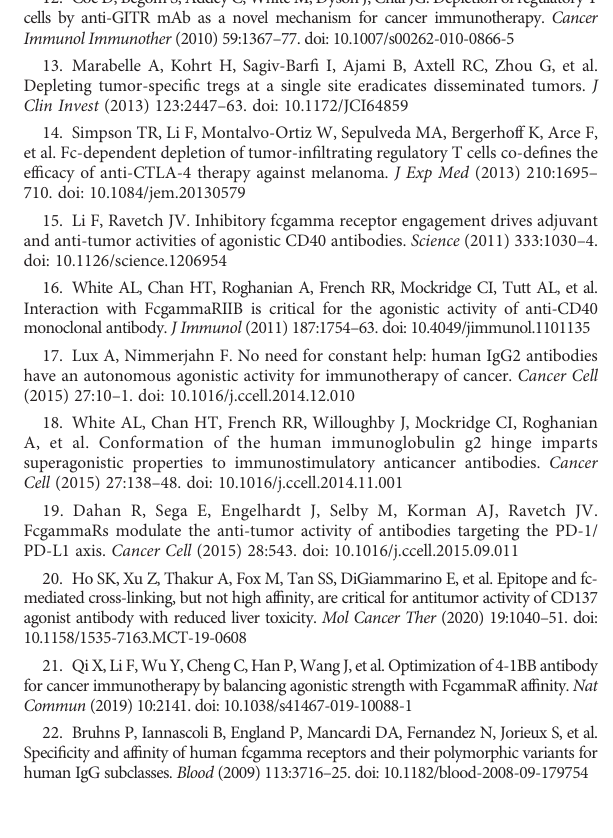
SUPPLEMENTARY FIGURE 5 Effect of urelumab variant injection on serum cytokine levels. Serum cytokine concentrations were determined before and at the indicated time-points after treating humanized mice with 3µg/g (A, C, E) or 6µg/g (B, D, F) of hIgG4, a CD137 or deglycosylated a CD137 PNGaseF variant. Depicted are serum concentrations of (A) IL-1 b (hIgG4: n=3, aCD137: n=6, a CD137 PNGaseF: n=4), (C) IL-8 (hIgG4: n=3, a CD137: n=6, a CD137 PNGaseF: n=4), and (E) IFN- a (hIgG4: n=4, a CD137: n=6, aCD137 PNGaseF: n=4) in mice treated with 3µg/g of the indicated antibody variants. Concentration of (B) IL-1 b (hIgG4: n=7, aCD137: n=9, aCD137 PNGaseF: n=5), (D) IL-8 (hIgG4: n=8, a CD137: n=8, a CD137 PNGaseF: n=4), and (F) IFN- a (hIgG4: n=9, a CD137: n=8, a CD137 PNGaseF: n=5), in mice treated with 6µg/g of antibody variants. Results are expressed as median of D MFI with interquartile range. A ROUT outlier test (Q=1%) and Shapiro-Wilk normality test were performed followed by either Friedman test with Dunn ’ s multiple comparison test or RM-One-Way ANOVA with Tukey ’ s multiple comparison test was